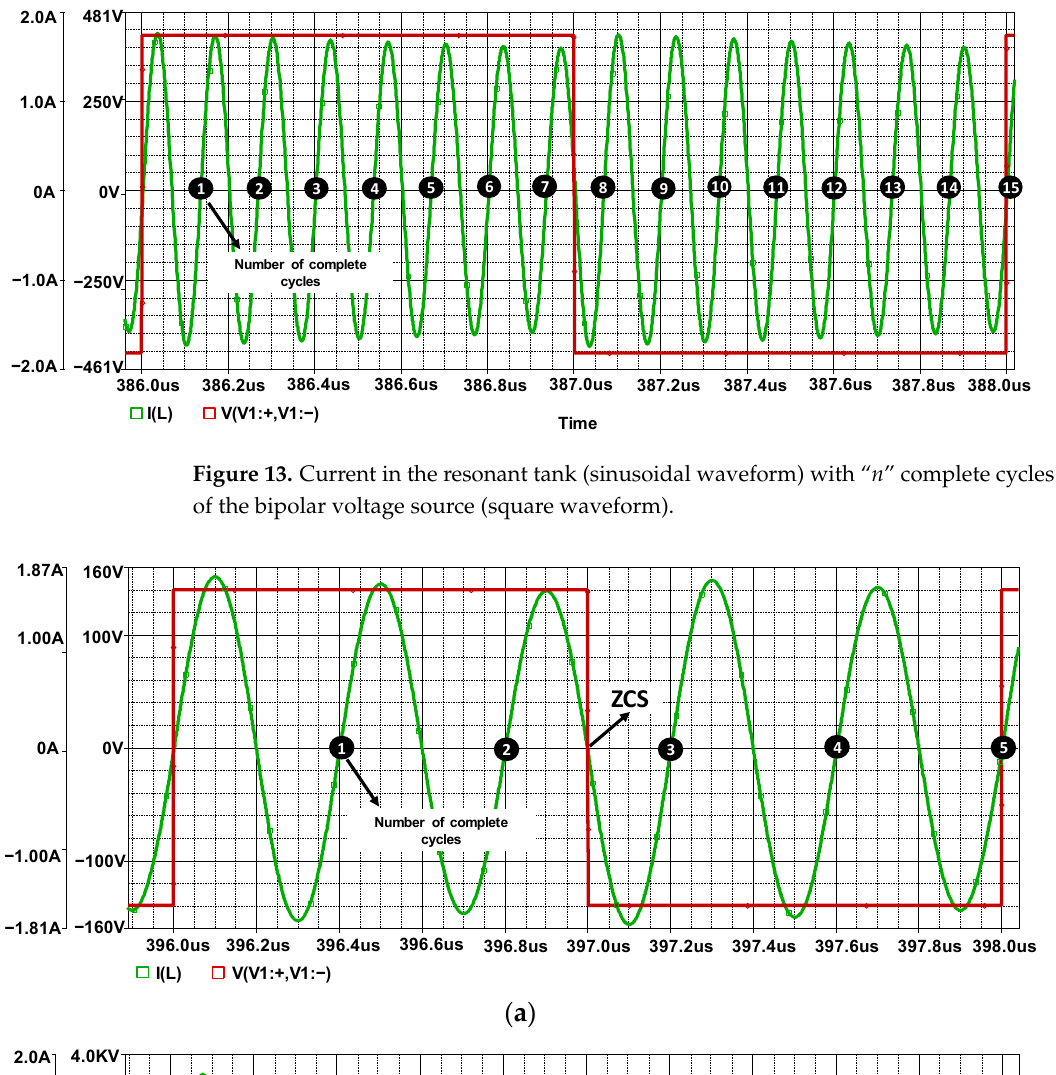
Figure 12. Voltage level on the resonant capacitor in the middle of the switching period ( V C = cV DC ) .